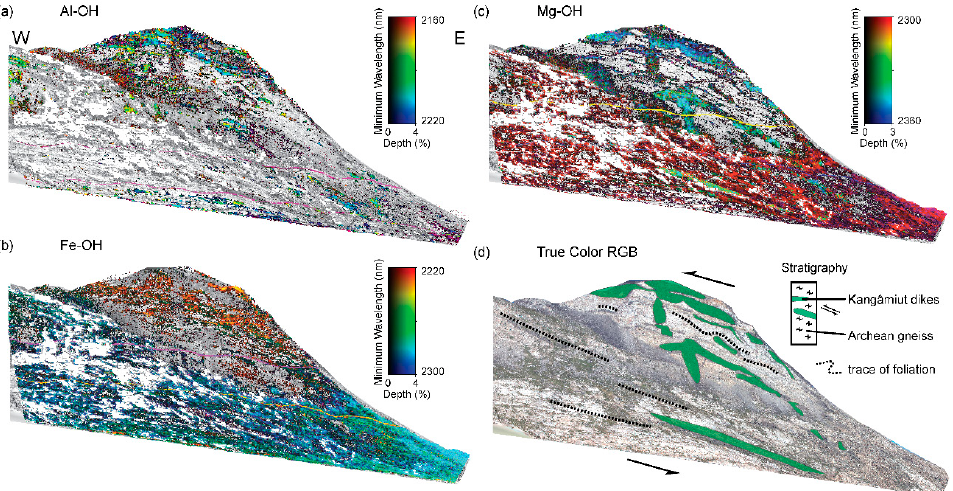
Figure 8. Wavelength position maps of the Søndre Strømfjord area, highlighting lithological variations associated with differences in the abundance of: ( a ) AlOH; ( b ) FeOH; and ( c ) MgOH bearing minerals draped on a grayscale pseudo-orthophoto. Non-geological material (such as vegetation) and areas strongly affected by shadows were masked and excluded from HIS data cubes before applying the wavelength mapping method and are indicated by white pixels. ( d ) Spatial context is provided by the true color pseudo-orthophoto. See Section 3.2.1 for a detailed description of matching hyperspectral products to the pseudo-orthophoto. possible to assess the material spatial variability, define end-members (Figure 9) and employ an unsupervised classification (i.e., SAM). Defining and clustering the end-members is the only expert- dependent parts of the analysis. In this particular hyperspectral dataset (Figure 10b,e), the first 15 eigenvectors of the MNF transformation contain coherent information, which can be used for further